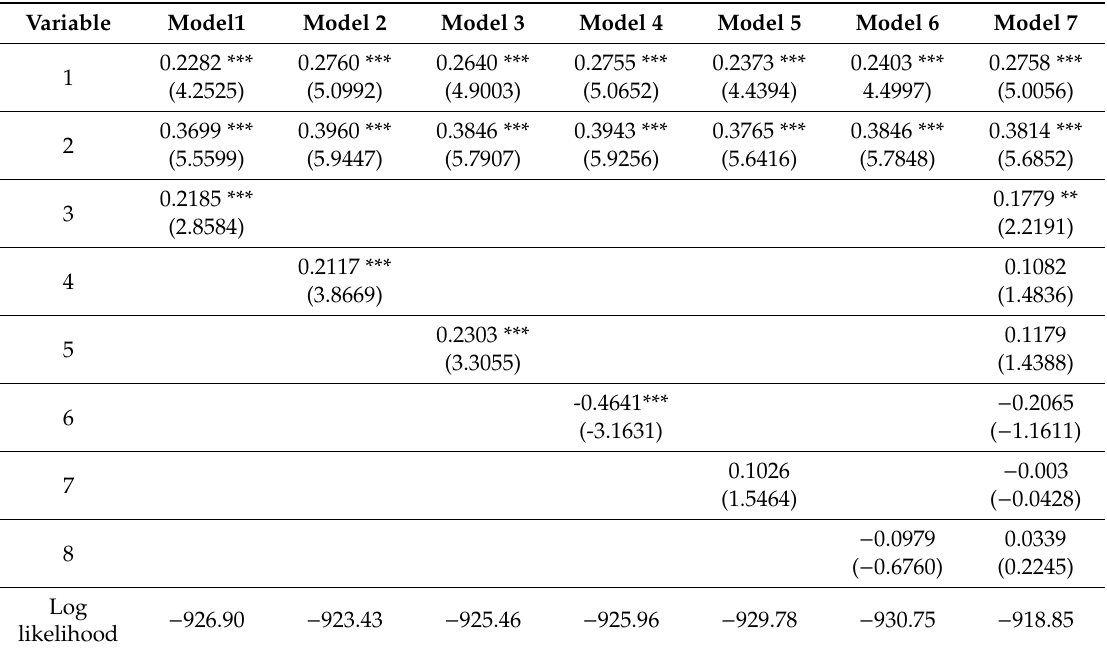
Table 2. The impact of perceived vulnerability on potential